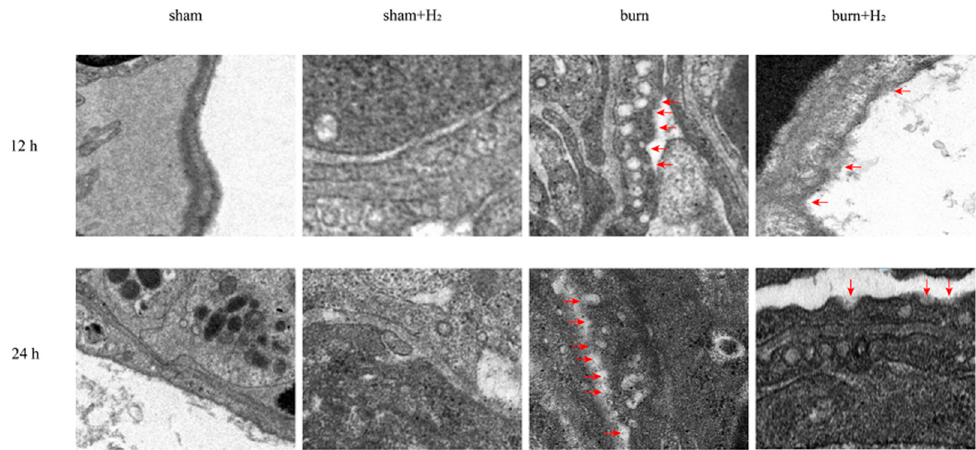
Figure 5. Hydrogen reduced the expression of GSDMD caused by burn. The distribution of GSDMD was detected by immunofluorescence at 12 and 24 h ( A ). The density of GSDMD was analyzed ( B , C ) (n = 4 rats per group). * p < 0.05.